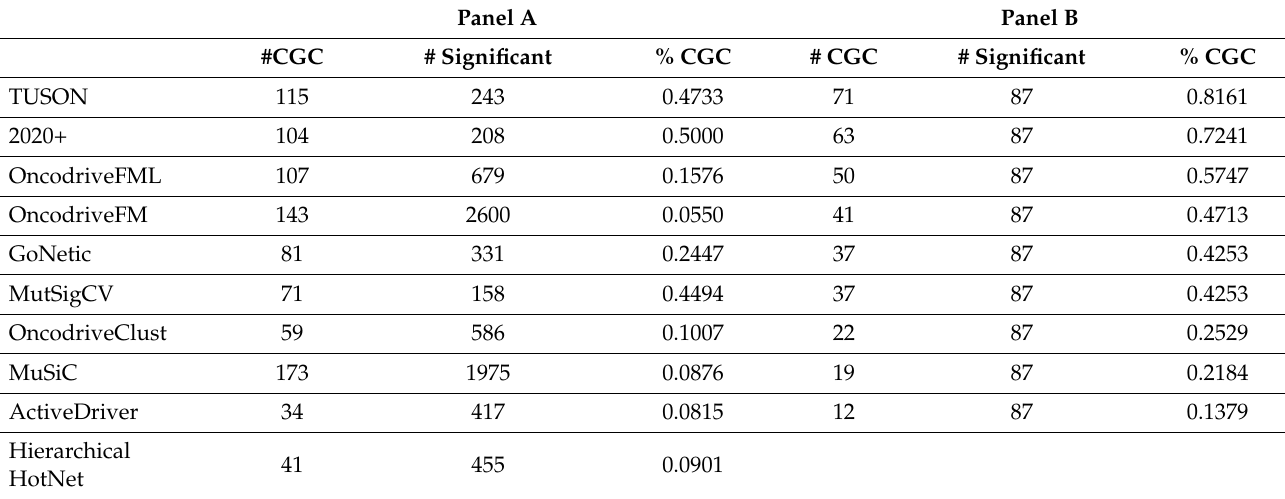
Table 1. CGC benchmark of different driver identification methods. #CGC: number of identified drivers that are in the gold standard CGC, #significant: number of driver genes prioritized by each method on the Tokheim data set. % CGC: positive predictive value or the number of true positive predictions (overlap with CGC) on the total number of predictions. Panel A. Considering, for each method, all the significantly identified drivers. Panel B. Considering, for each method, the top 87 predicted